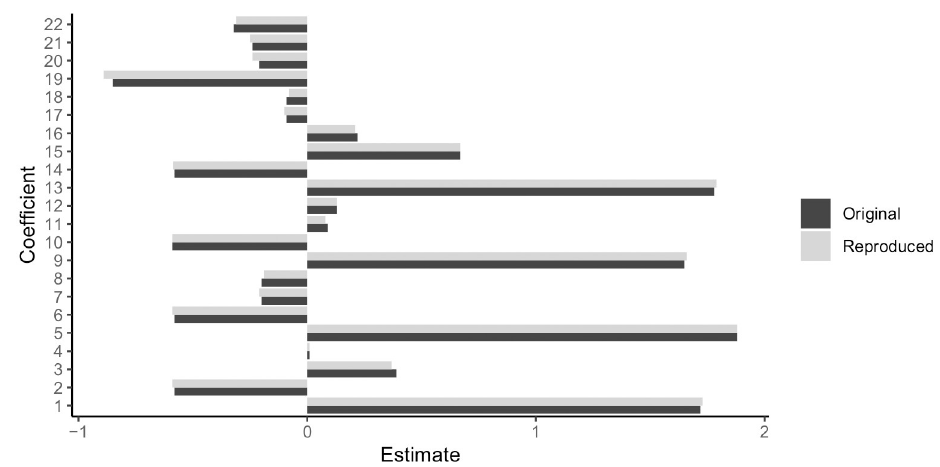
Fig 2. Original and reproduced model parameter estimates for the ewbGEE model of article [15]. In this article the differences in parameters do not lead to a different interpretation.